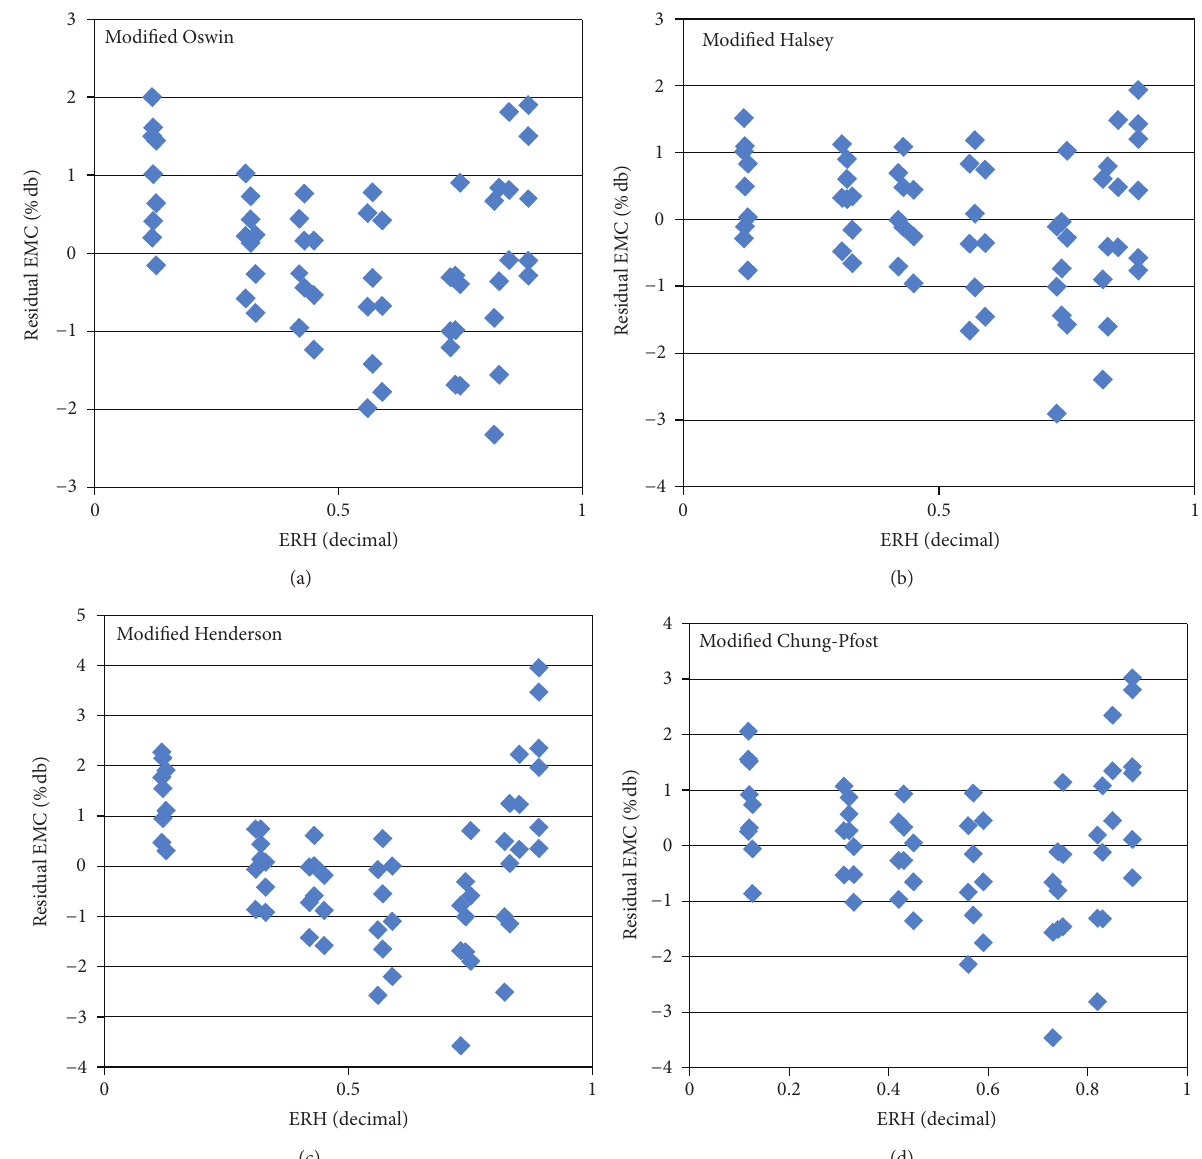
Figure 3: Residual plots of the fitted isotherm equations for the moisture isotherm data of big bluestem at temperatures 20 to 40 ∘ C.